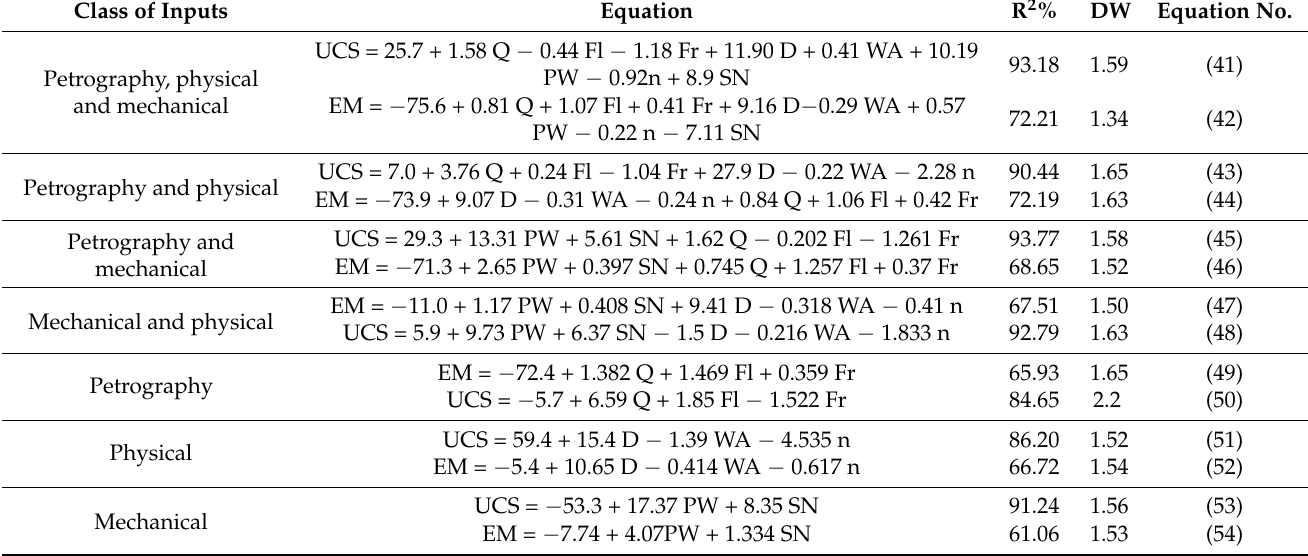
Table 4. Developed regression equations to estimate static